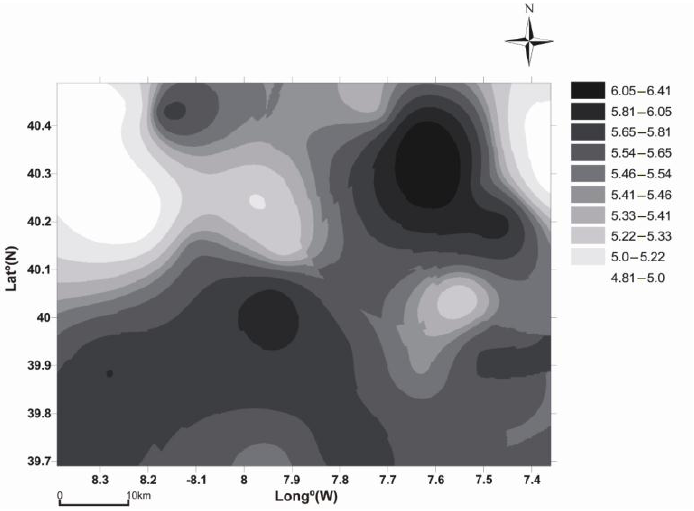
Fig. 6. Spatial distribution of (Ln)P95 according to SPT interpolation